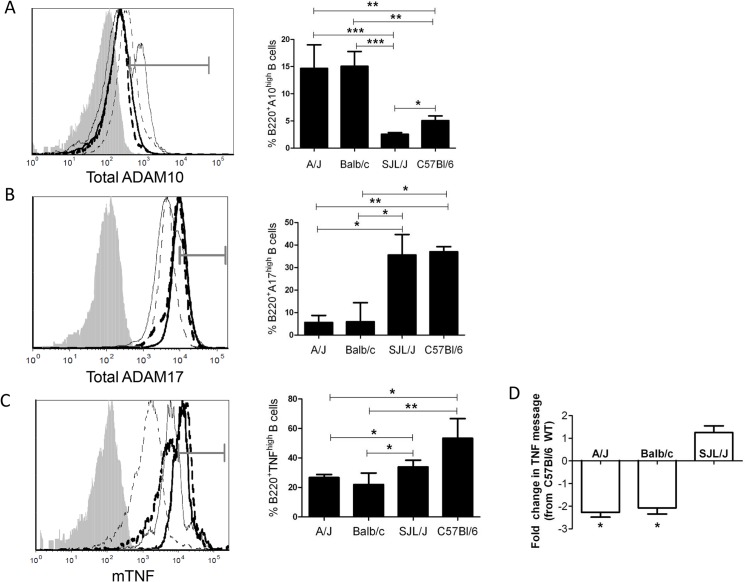
Increased B-ADAM10 and decreased ADAM17 and TNF in Th2 biased strains.Naïve B220+ B cells (A, B) stained for total ADAM10 (A) or ADAM17 (B) expression by flow cytometry. (C) TNF coexpression on 3 day stimulated (anti-CD40+IL4) B220+ B cells by TSA. (A,B,C) Bar graph represents percent total B cells staining high in ADAM10 (A), ADAM17 (B), or TNF (C). (A,B,C) Balb/c (──)A/J (——), C57Bl/6 (▬▬), SJL (▪▪▪▪▪), respective isotype control (shaded grey) in representative overlay (left); grey gate demonstrates high stained population. n = 8 per group, 3 independent studies. *p<0.05, **p<0.005, ***p<0.0005. (D) TNF message from 3 day stimulated (anti-CD40 + IL4) B220+ B cells. Presented as fold change from C57Bl/6 WT. * signifies ≥2 fold change between C57Bl/6 WT and the listed WT strain.